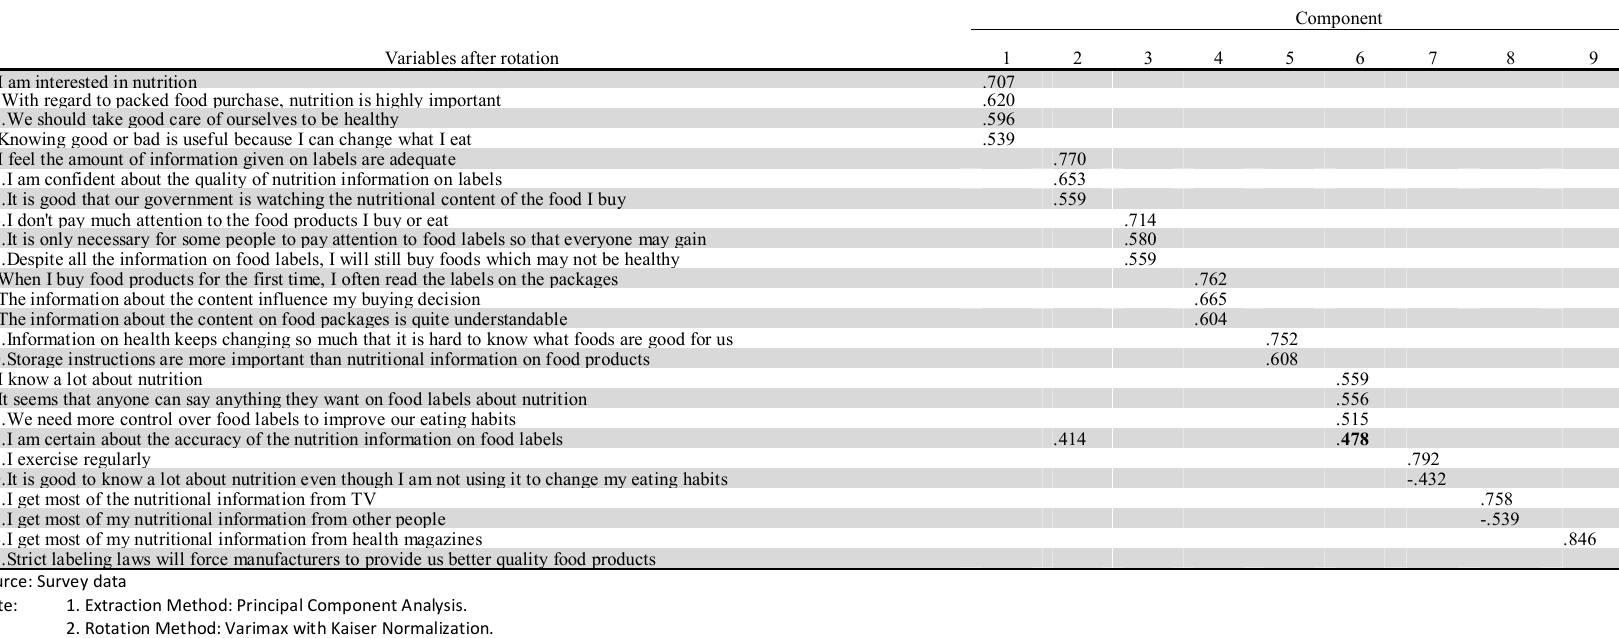
Variables after